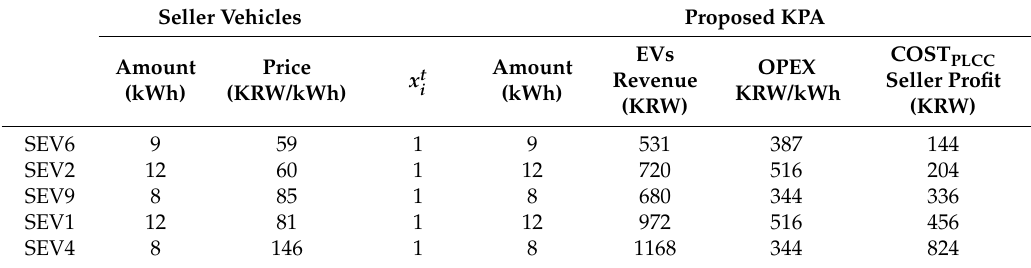
Table 7. Case (1) with the Knapsack Algorithm (KPA) scheme for electric vehicles as sellers and the PLCC as a